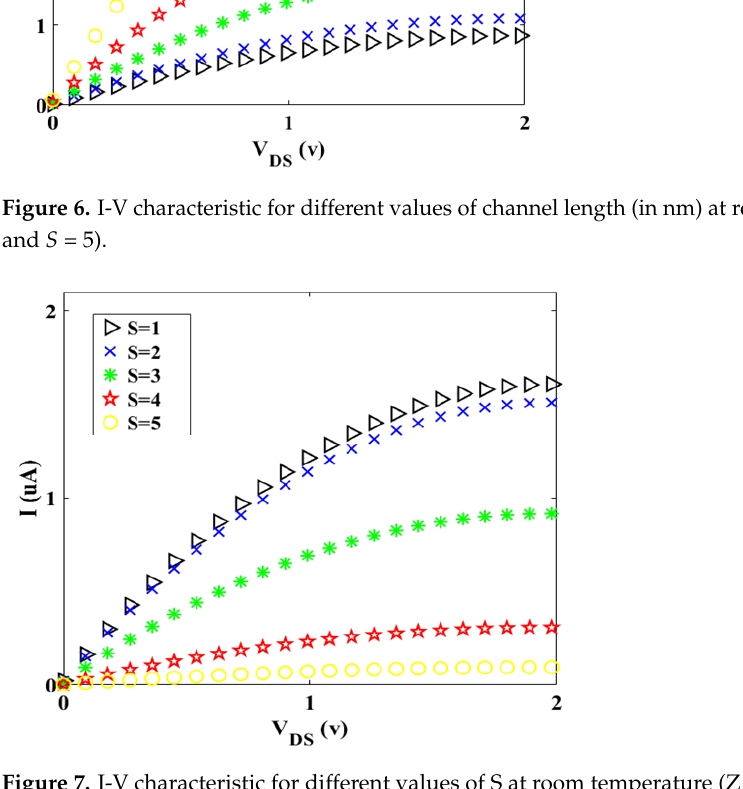
Figure 7. I-V characteristic for different values of S at room temperature (Z = 10).